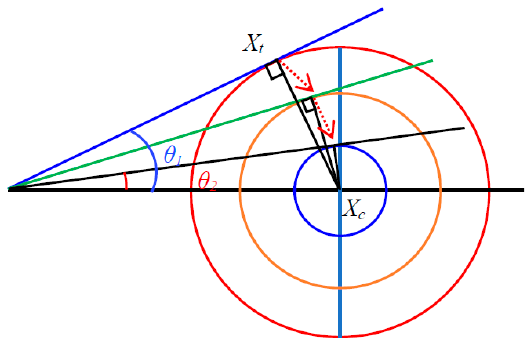
Figure 1. The decrease in the angle for exploitation in the CSA.